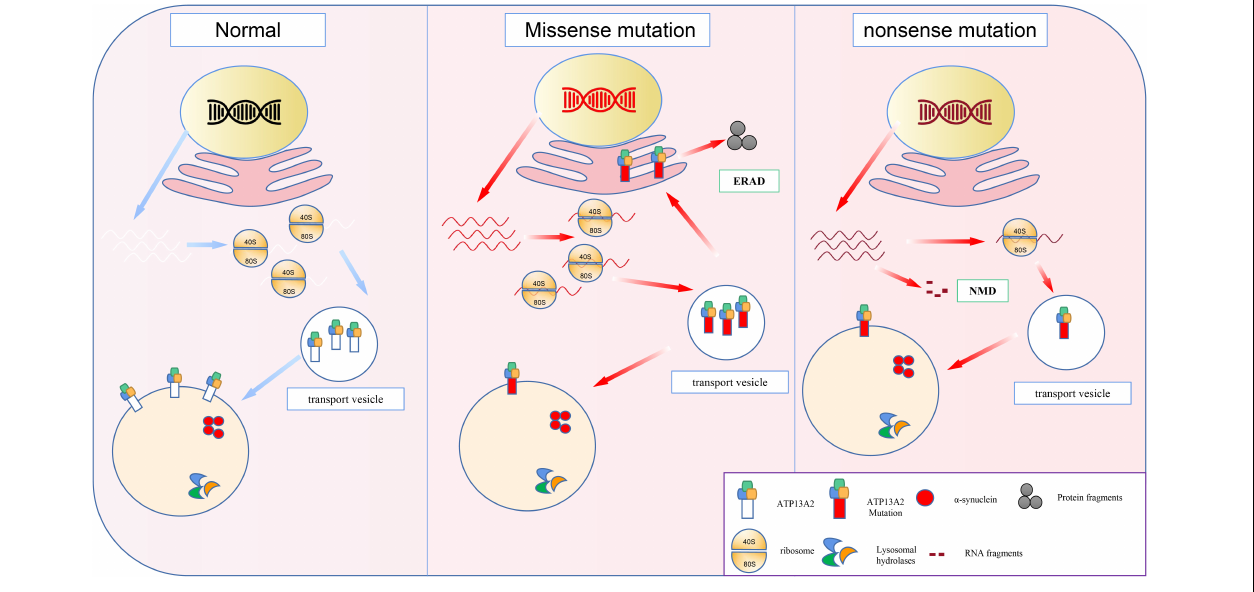
Frontiers in Cellular Neuroscience |